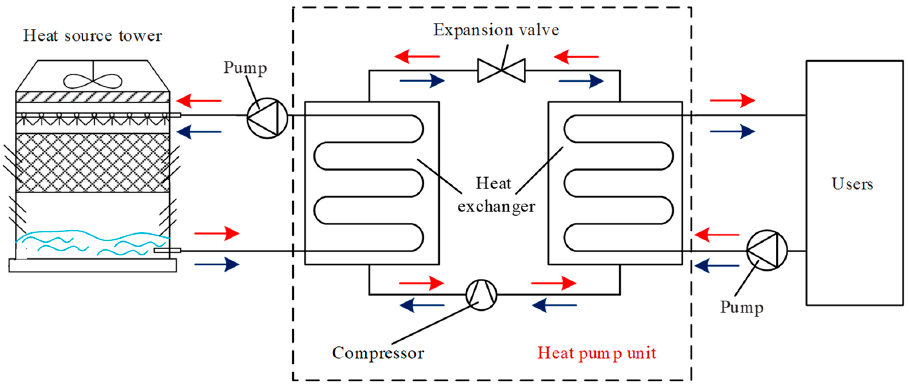
Figure 2. Schematic of the HST operating mode.